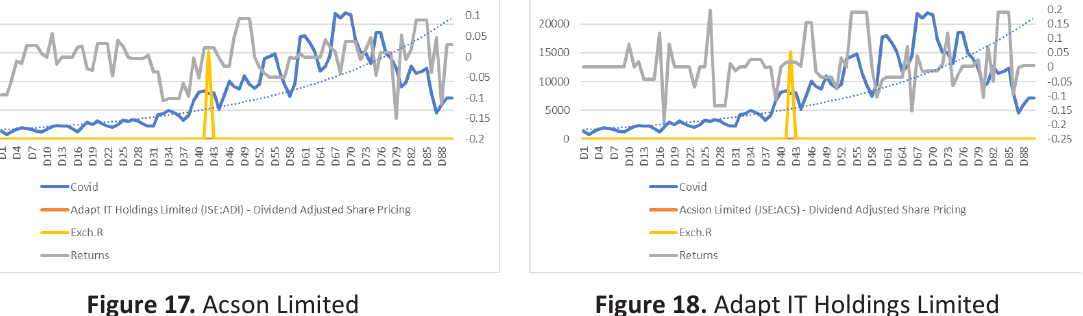
Figure 17. Acson Limited Figure 18. Adapt IT Holdings Limited